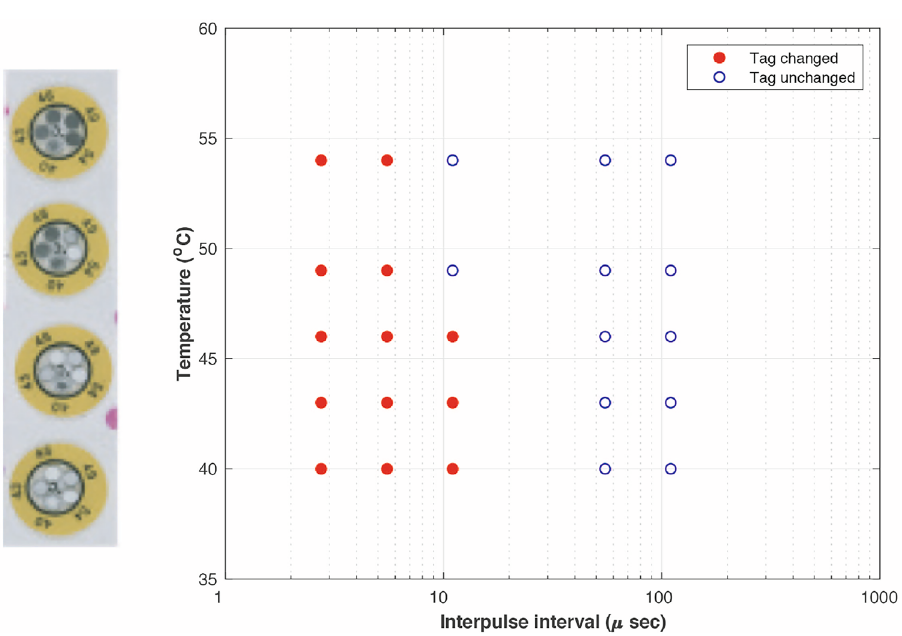
Figure 15. Response of temperature indicator discs to a range of interpulse intervals for a duration of 18 min (RF 1.2 GHz, 550 ns pulse), (n =